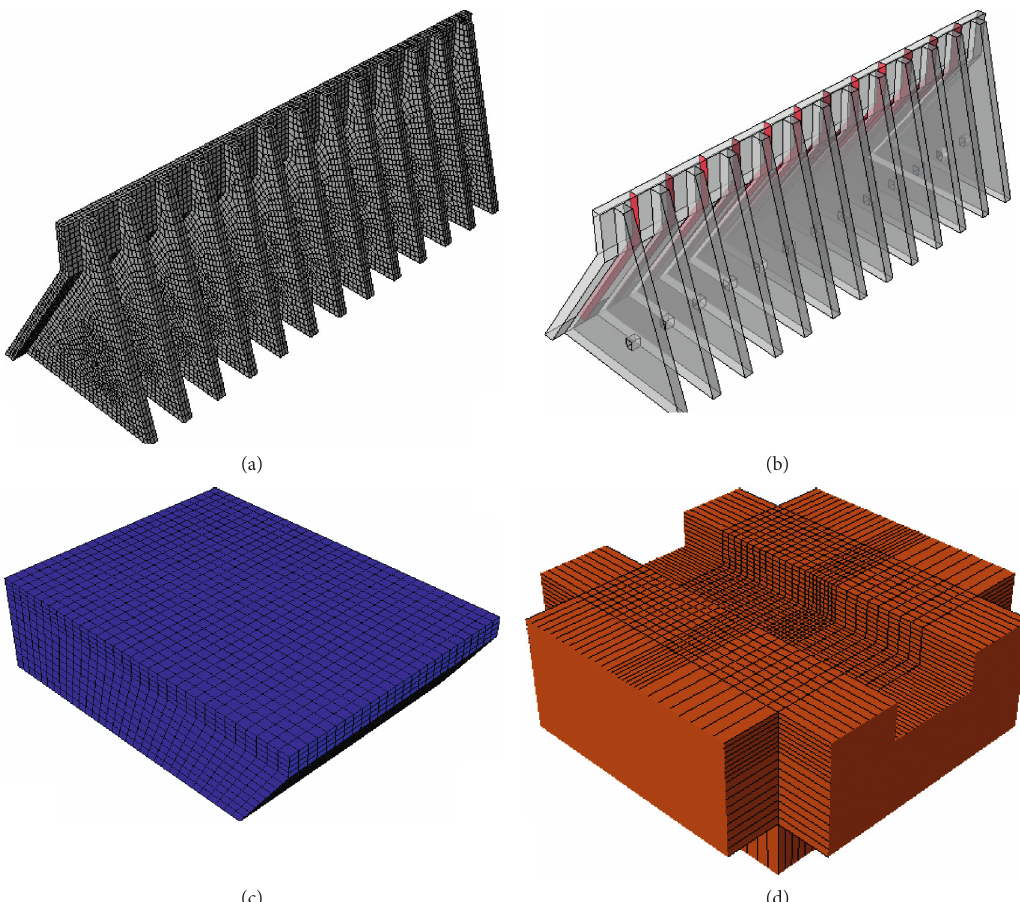
Figure 4: FE models of the studied concrete buttress dam (a), layout of contraction joints (b), reservoir (c), and rock foundation